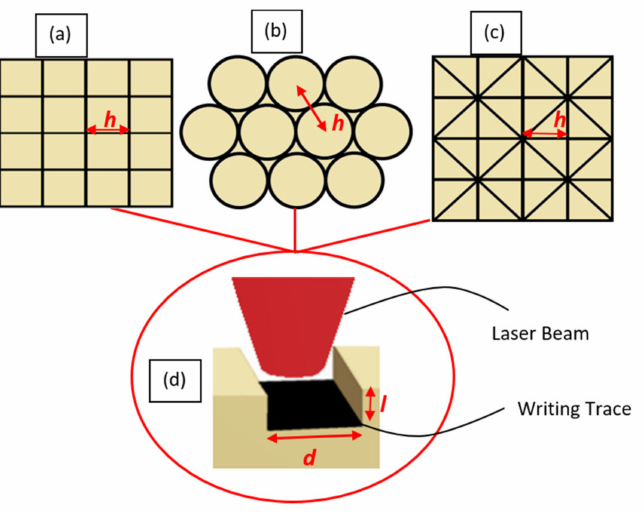
Figure 3. Sketch of the three different laser textured geometries: ( a ) square lattice; ( b ) hexagonal-circle lattice; ( c ) triangular lattice. The pitch h , the diameter of the focal spot d and the depth of the ablated groove l are highlighted in panel ( d